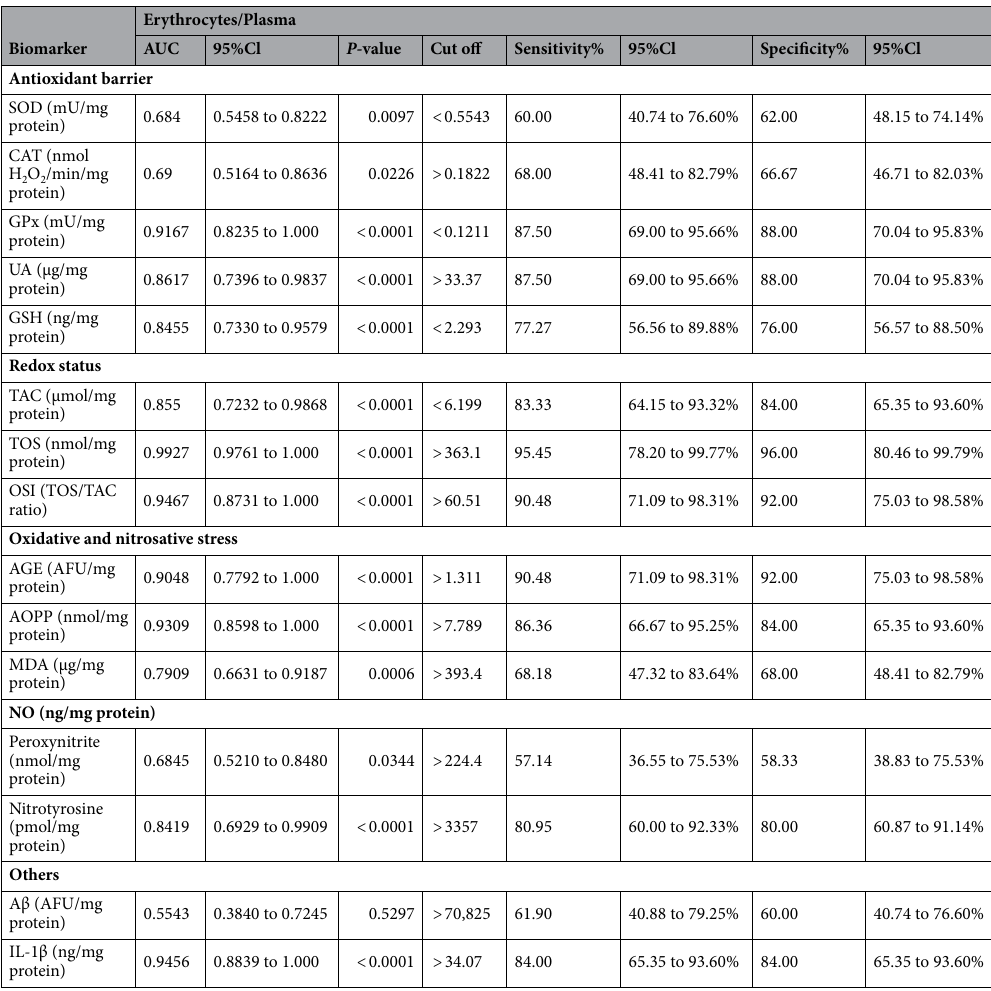
Table 5. Receiver operating characteristic (ROC) analysis of redox biomarkers in erythrocytes/plasma of patients with Alzheimer’s disease and the control group. AUC—area under curve; SOD—superoxide dismutase; CAT—catalase; GPx—glutathione peroxidase; UA—uric acid; GSH—glutathione; TAC—mean total antioxidant capacity; TOS—mean total oxidant status; OSI—oxidative stress index; AGE—advanced glycation end products; AOPP—advanced oxidation protein products; MDA—malondialdehyde; NO—nitric oxide, Aβ—amyloid beta; IL-1β—Interleukin 1